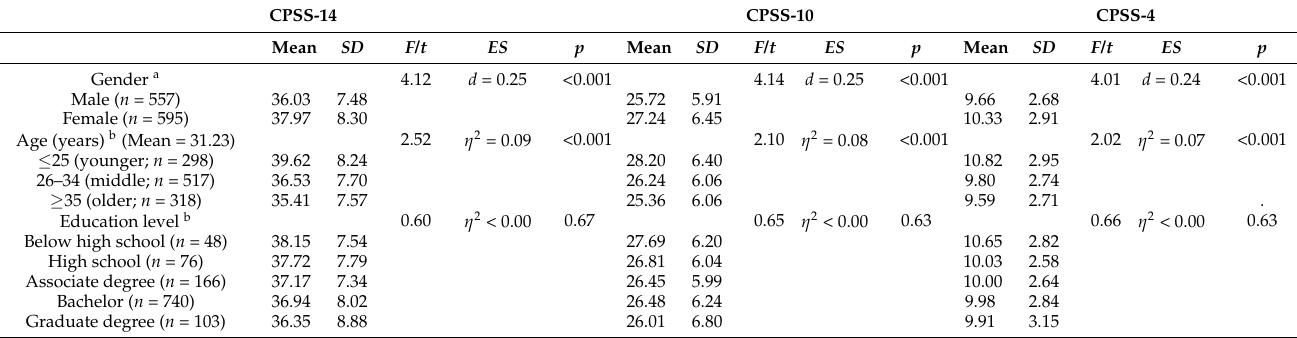
Table 5. Mean differences by gender, age, and educational